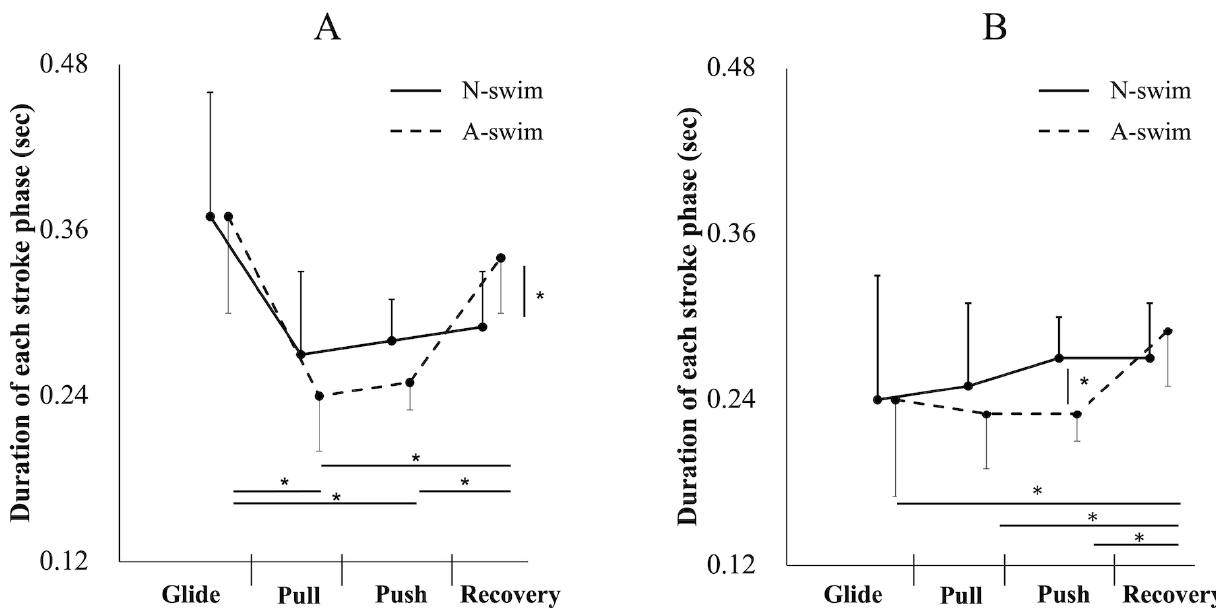
Fig. 3. Duration of each stroke phase (s). (A) Submax and Max effort during N-swim (solid line) and A-swim (dotted line). (B) Data are means ±